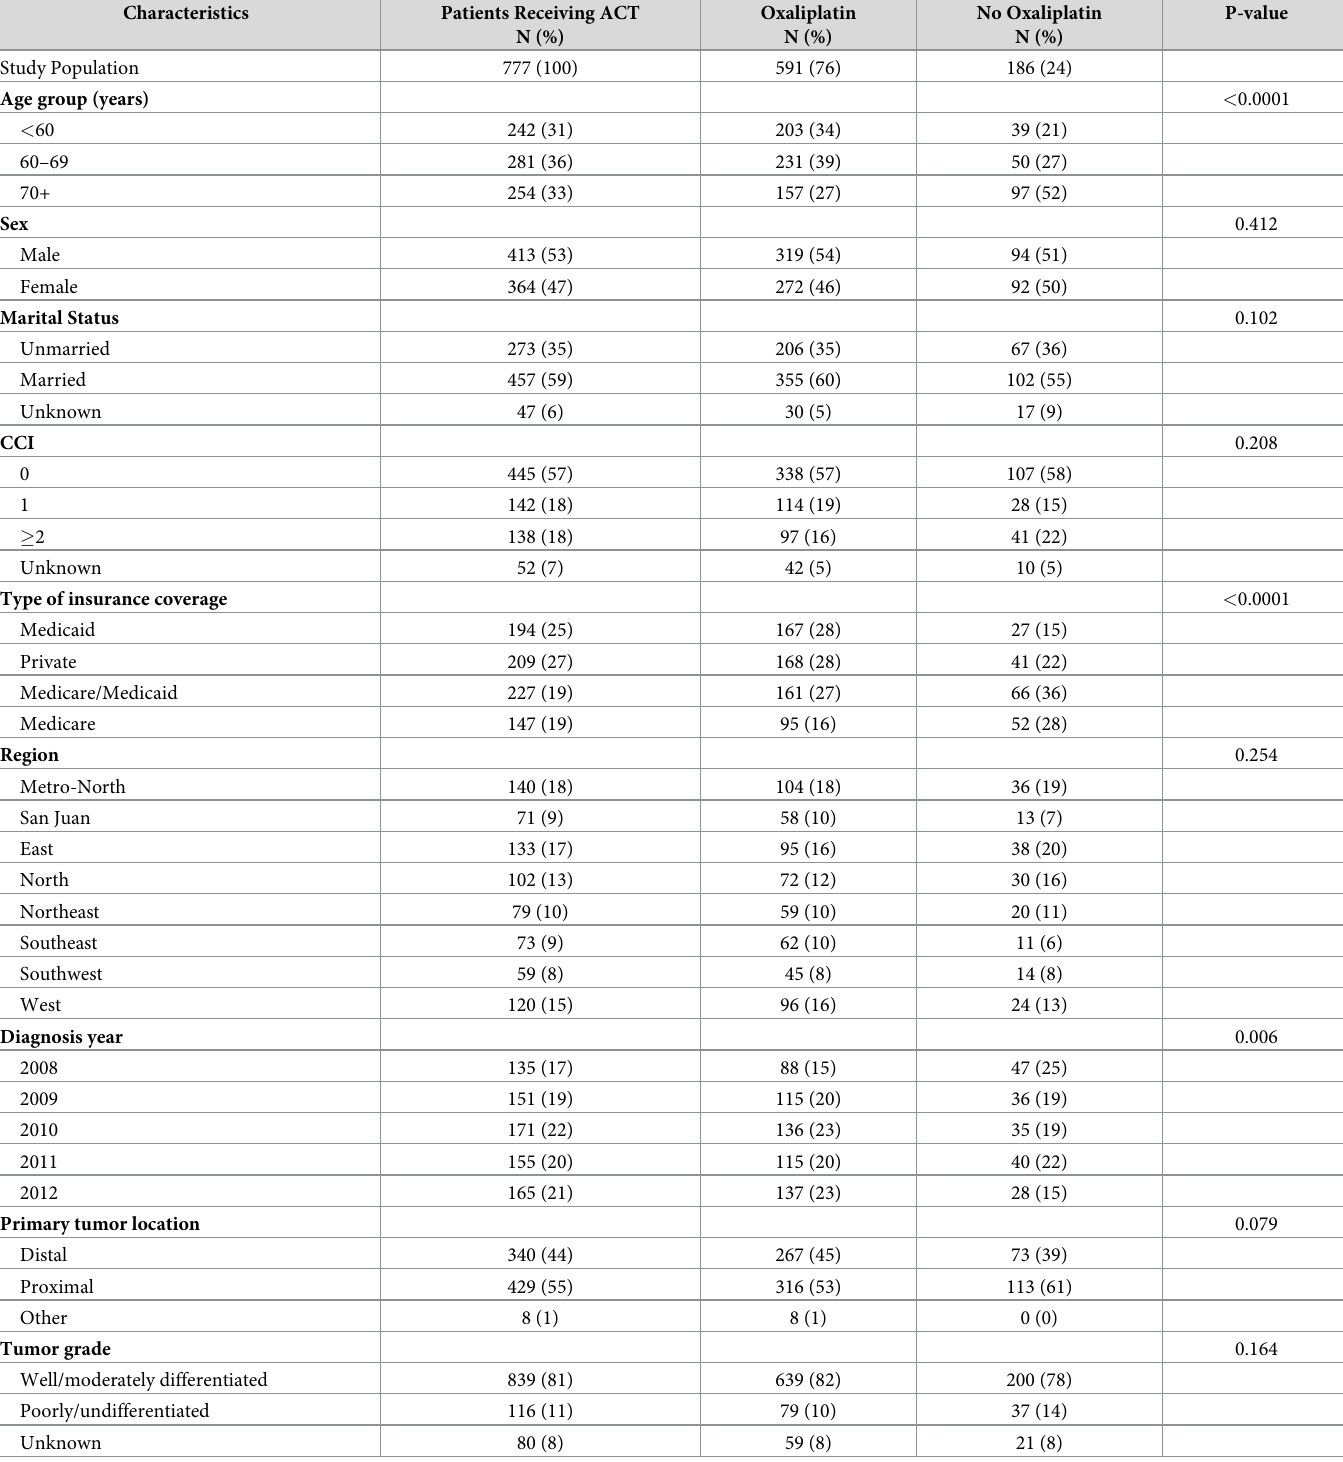
Table 3. Characteristics of stage III colon cancer patients who used ACT by oxaliplatin Receipt status.